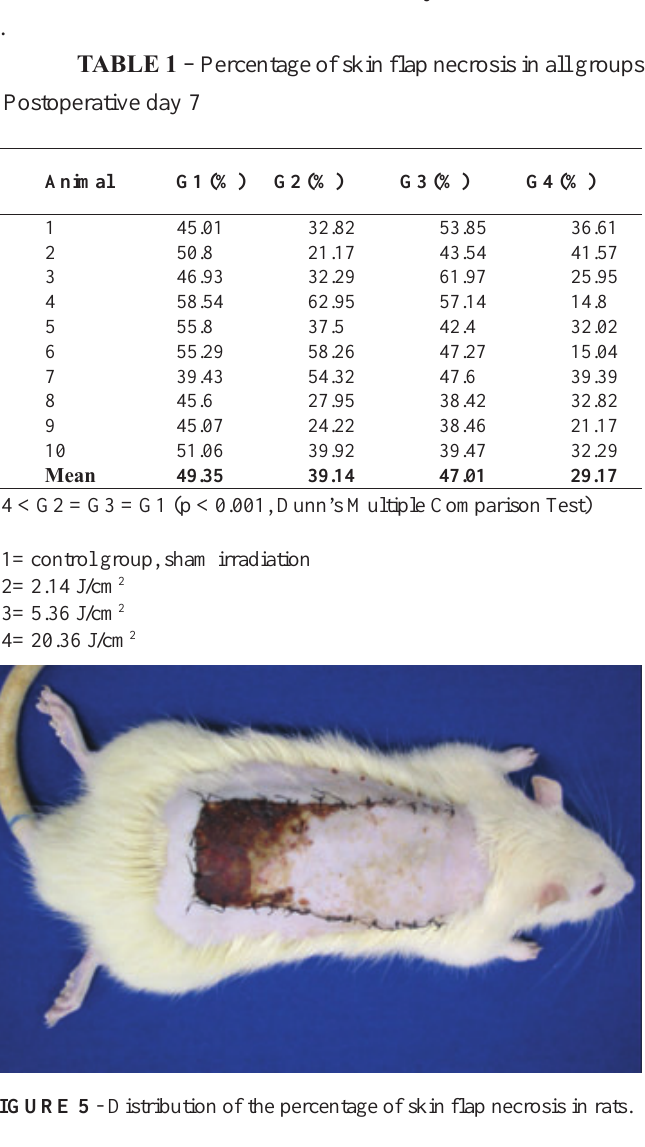
FIGURE 6 - Mean area of necrosis in skin flaps of animals in the G1 group on postoperative day